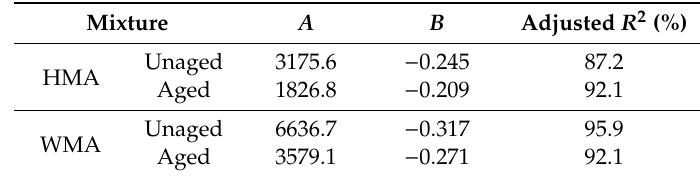
Figure 10. Results of fatigue test. Table 6. Fitting fatigue laws’ parameters.